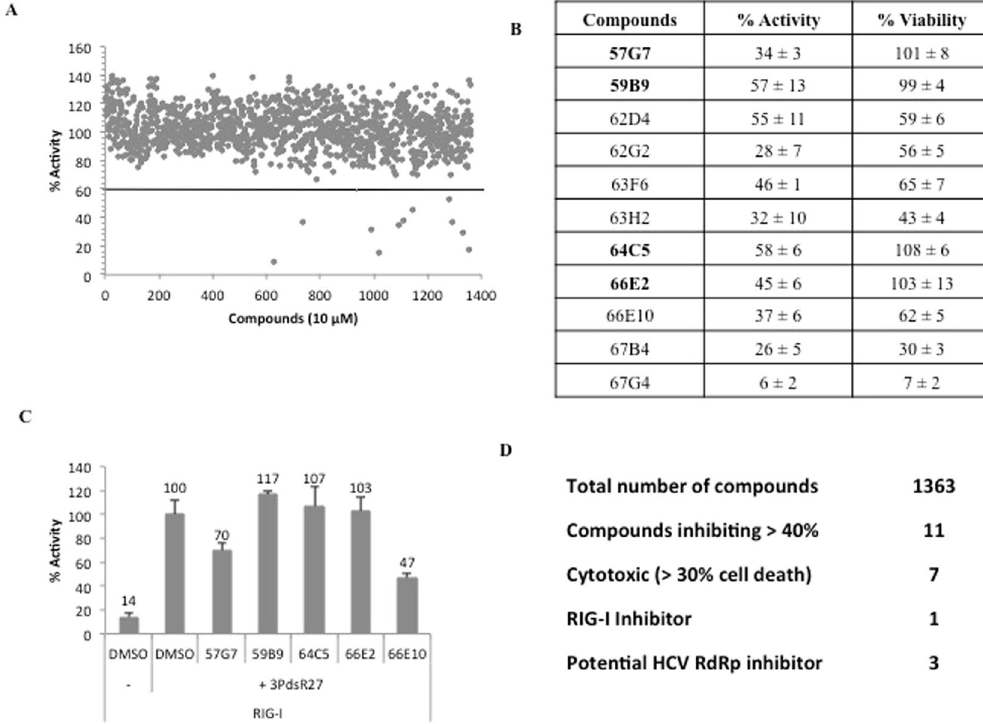
Figure 1. Cell-based screening. ( A ) Each circle represents the mean % of the ratio of firefly luciferase to Renilla luciferase (referred to as % Activity) for a given compound tested at 10 μ M in duplicate for 48 h. 11 compounds showed values less than 60% (horizontal line). ( B ) The same 11 compounds were retested in the cell-based assay in triplicates and their cytotoxicity analyzed using WST assay. The results are representative of three independent assays. The means and standard deviations of each result are shown. The values correspond to the ratio of firefly luciferase to Renilla luciferase (% activity) and % of live cells (% viability) upon treatment with respective compounds at 10 μ M. The compounds in bold are the ones that inhibited NS5B activity without exhibiting any cell toxicity. ( C ) RIG-I assay to test the specificity of the compounds. Compounds that showed more than 40% inhibition without any cytotoxicity in B were tested along with the cytotoxic compound 66E10. RIG-I was induced with a 27 bp triphosphorylated dsRNA, 3P dsR27. The % activity is plotted against each compound with DMSO as control. % Mean is shown above the bars and the error bars are standard